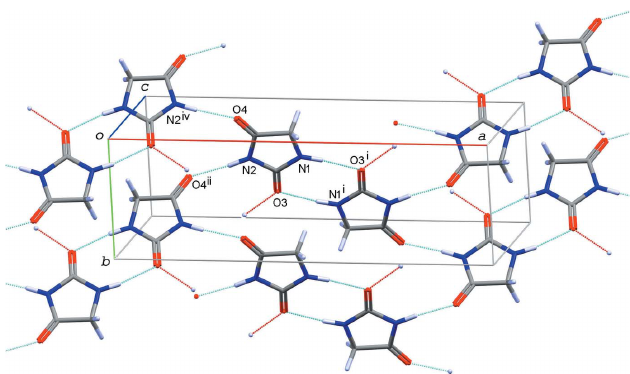
Figure 4 A partial packing diagram of compound (II) viewed approximately along the b axis, showing a hydrogen-bonded tape structure formed by acid molecules and pairs of base molecules. O—H (cid:2)(cid:2)(cid:2) O and N—H (cid:2)(cid:2)(cid:2) O hydrogen bonds are shown by light-blue dotted lines. [Symmetry codes: (i) (cid:4) x + 1, (cid:4) y + 1, (cid:4) z + 1; (iii) (cid:4) x + 1